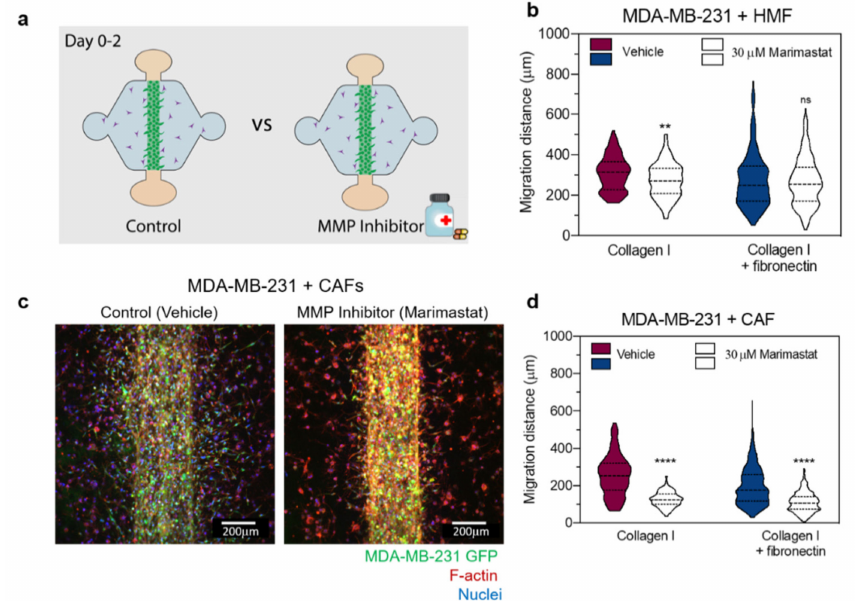
Figure 5. E ff ect of MMP inhibition on cancer cell migration. ( a ) Schematics of the experimental conditions. Co-cultures within the di ff erent matrices were treated for 48 h with 30 µ M marimastat (MMP inhibitor) and a Dimethyl sulfoxide (DMSO) vehicle (control). ( b ) Migration distance of MDA-MB-231 in co-cultures with HMFs in the collagen matrix (left) and the fibronectin-rich matrix (right) for the vehicle control and treatment. ( c ) Representative image of the co-culture with CAFs for the vehicle control (left image) and treatment with 30 µ M marimastat (right image). ( d ) Migration distance of MDA-MB-231 in co-cultures with CAFs in the collagen matrix (left) and the fibronectin-rich matrix (right) for the vehicle control and treatment with 30 µ M marimastat. The Violin plots represent the distribution of the data with the average and SD, n = 3 for at least four individual devices. ** p < 0.01 and **** p <